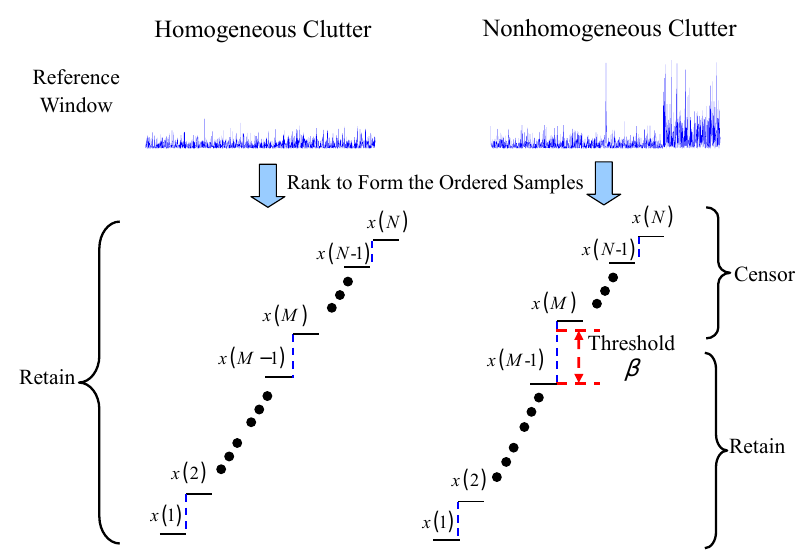
Figure 2. The idea behind first-order difference